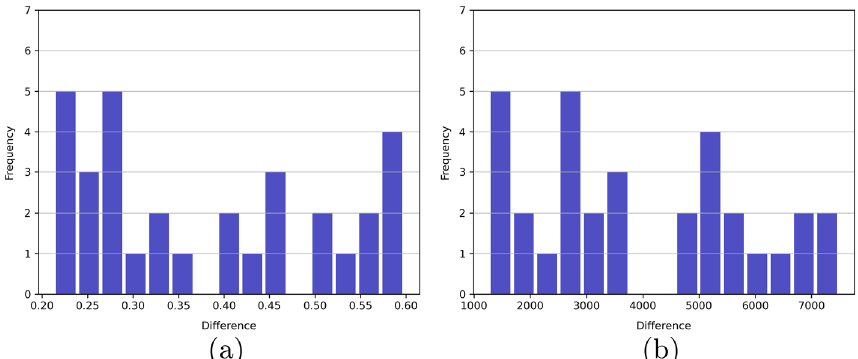
Fig. 3 Differences in the number of messages between the YTQ method and our pruning method on the 32 autonomous graphs. Positive values indicate that our pruning method outperfoms the YTQ method. (3a ): Reduction in the average number of messages. (3b) : Reduction in the maximum number of